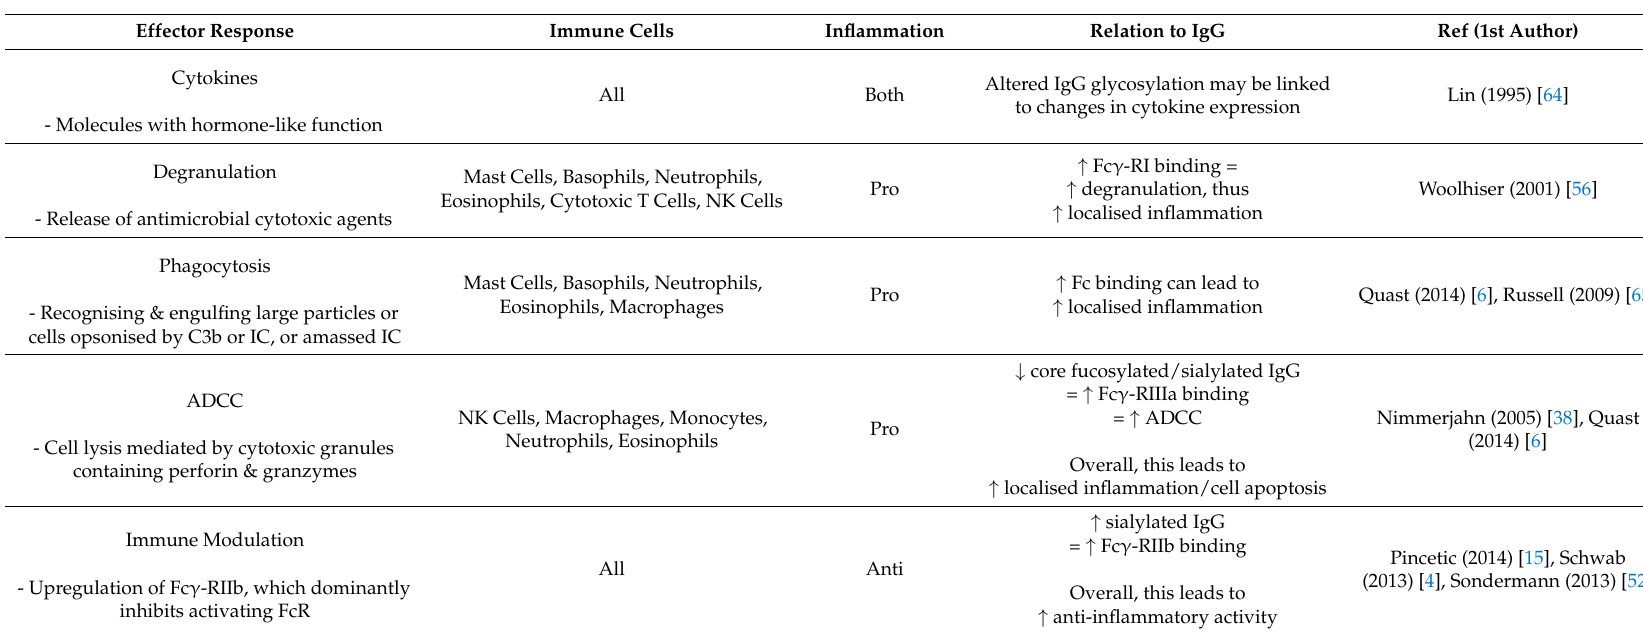
Table 2. Summary of FcR effector responses elicited by IgG binding. IgG N -glycosylation of the Fc domain is directly linked to changes in affinity for FcRs that either produce more pro-inflammatory responses (ADCC) or anti-inflammatory responses (immune modulation). Anti-inflammatory activity is said to be